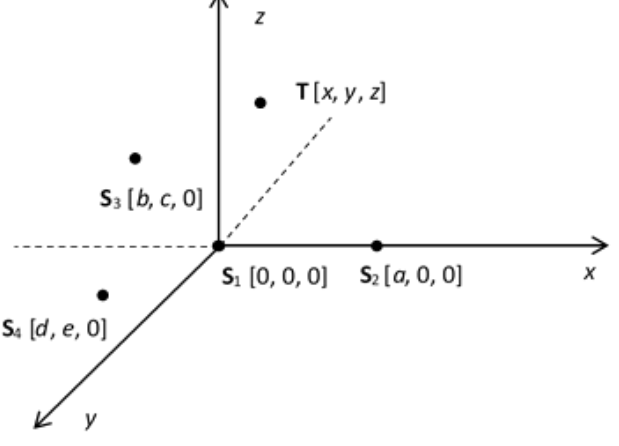
Figure 1. The sensor network and the target arrangement.